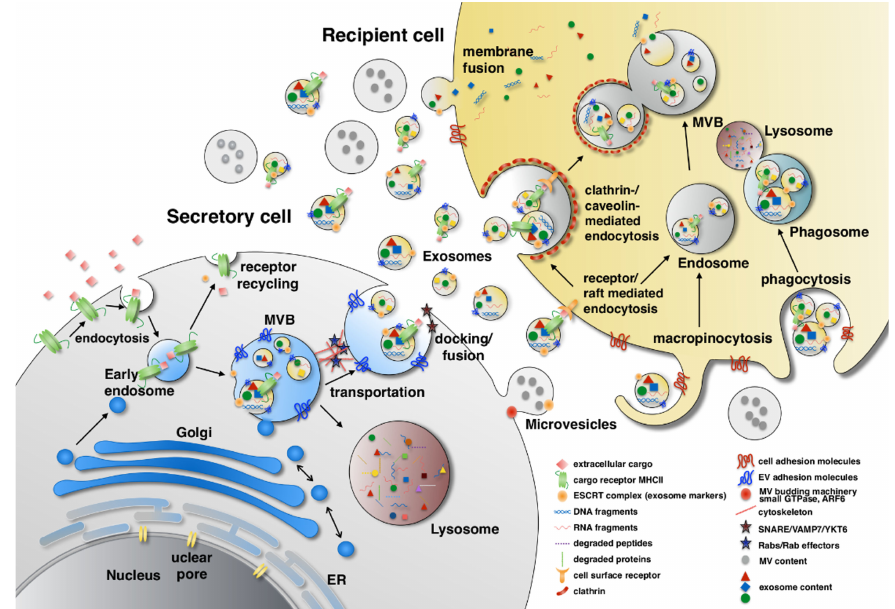
Figure 1. Extracellular vesicles (EV) biogenesis. The EV contents come from three sources: extracellular, intracellular and plasma membrane. Extracellular and plasma membrane molecules enter the early endosome through endocytosis either selectively by cargo receptor (ubiquitinated MHC-II) recognition or non-selectively. In the late endosome, the endosomal sorting complexes required for transport, ESCRT and their associated proteins such as TSG101, Alix, α -arrestin1 and CHMP4 mediate membrane inward invagination and form exosomes within multi-vesicular body (MVB). During the vesicle forming process, certain cytosolic components such as DNA, RNA and proteins are included in the exosome. MVBs can turn into lysosomes and degrade their contents or dock and fuse with the plasma membrane to release their contents to the extracellular space. The transportation and docking of MVBs is mediated by cytoskeleton remodeling which is regulated by Rab GTPase proteins (e.g., Rab27 α , Rab27 β and Rab7) and their effectors (e.g., SYTL4 and SLAC2B), whereas the fusion of MVBs with the plasma membrane is mediated by SNARE, VAMP7 and YKT6. In contrast, microvesicles are formed by outward budding of the plasma membrane which involves actin-myosin machinery, small GTPase and ARF6. The content sorting in microvesicles also involves TSG101. EV uptake is initiated by adhesion of EVs to the surface adhesion molecules on recipient cells, such as integrins, ICAM-1/LFA-1, CD11a, CD49d, CD44, CD169, heparin sulfate proteoglycans and by CD9, CD81 on EVs. EVs are then internalized through fusion, phagocytosis, macropinocytosis and endocytosis. ESCRT: Endosomal sorting complexes required for transport; TSG101: Tumor susceptibility gene 101; Alix: ALG-2-interacting protein X; CHMP4: Chromatin-modifying protein/charged multivesicular body protein; SYTL4: Synaptotagmin like 4; SLAC2B: Slp homolog lacking C2 domain B; SNARE: SNAP receptor; VAMP7: Vesicle associated membrane protein 7; YKT6: v-SNARE homolog ( S. cerevisiae ); ARF6: ADP-ribosylation factor 6; ICAM1: Intercellulare adhesion molecule 1; LFA1: Lymphocyte function-associated antigen